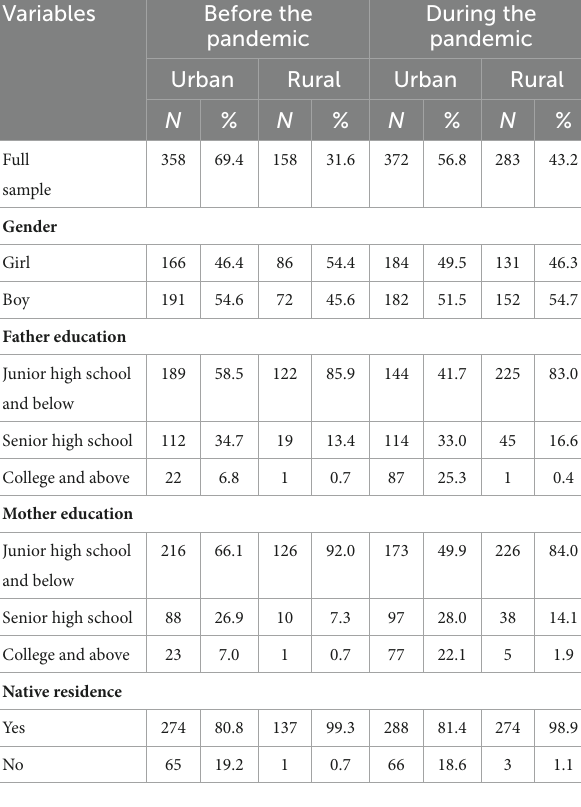
TABLE 1 Basic characteristics of socioeconomic indicators.